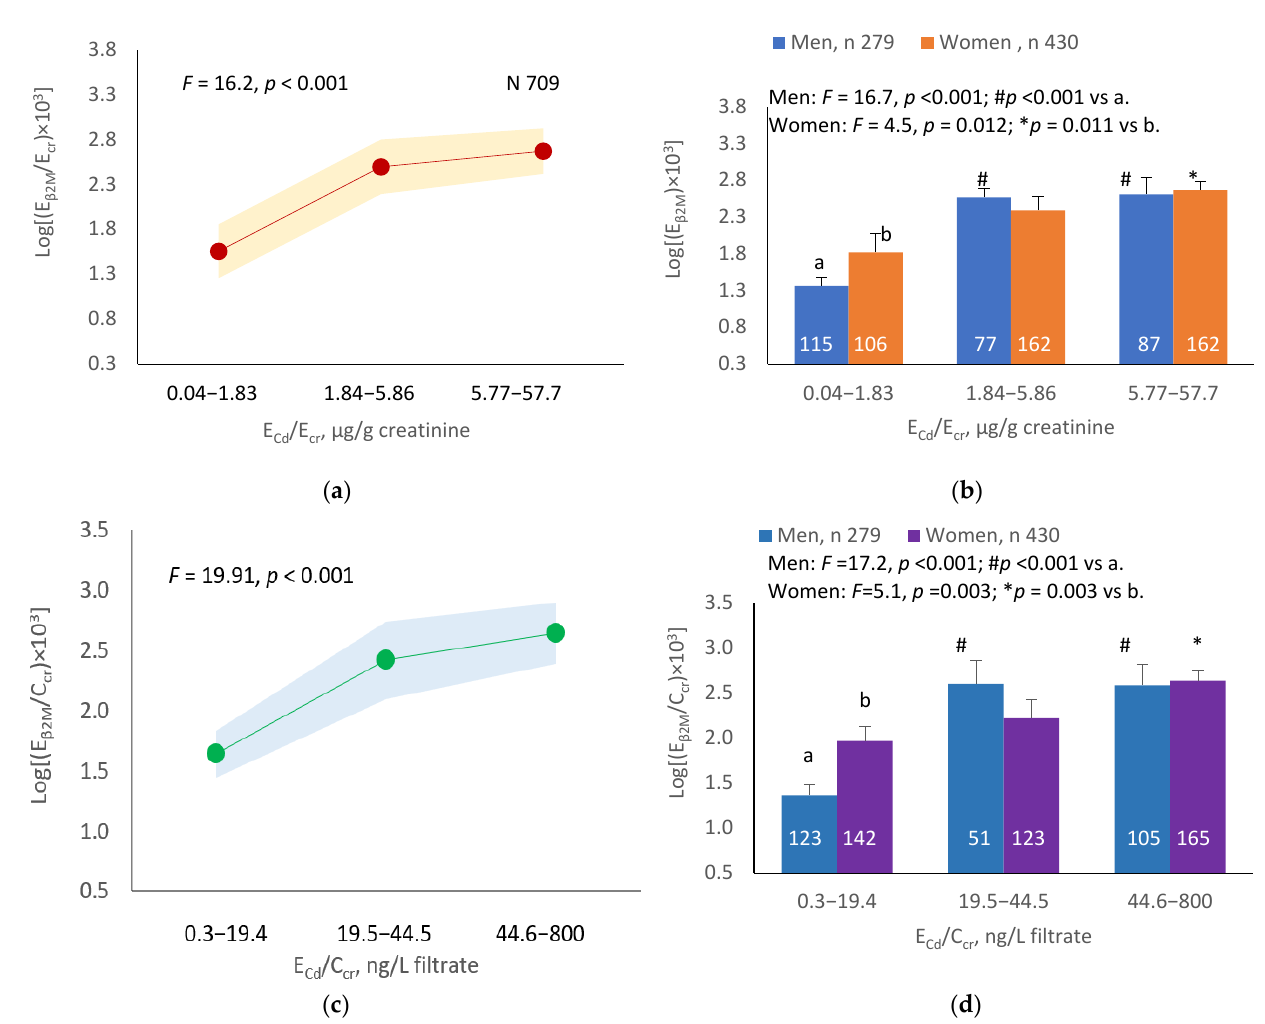
( d ) Figure 2. Cadmium-dose-related increases in NAG excretion. The color-coded area graphs depict NAG excretion means as log[(E NAG /E cr ) × 10 3 ] values with variances for subjects with E Cd /E cr Levels 1, 2 and 3 ( a ) and NAG excretion means as log[(E NAG /C cr ) × 10 4 ] with variances in subjects with E Cd /C cr Levels 1, 2 and 3 ( c ). The bar graphs show NAG excretion means as log[(E NAG /E cr ) × 10 3 ] values in men and women with E Cd /E cr Levels 1, 2, and 3 ( b ) and NAG excretion means as log[(E NAG /C cr ) × 10 4 ] in men and women with E Cd /C cr Levels 1, 2 and 3 ( d ). Where appropriate, statistical comparisons are made within each sex between NAG excretion means in bars a and b. The GM (SD) values of E Cd /E cr at Levels 1, 2 and 3 are 0.51 (0.50), 3.43 (1.10) and 10.94 (7.33) µg/g creatinine, with the corresponding number of subjects being 221, 239 and 249, respectively. The GM (SD) values of E Cd /C cr at Levels 1, 2 and 3 are 5.18 (5.72), 29.6 (6.73) and 97.3 (97.7) ng/L filtrate, with the corresponding number of subjects being 265, 174 and 270, respectively. 3.5.3. Cadmium-Dose-Dependent Increases in β 2 M Excretion The mean E β2M /E cr was highest at E Cd /E cr Level 1, intermediate at Level 2 and lowest at Level 3 ( p < 0.001) (Figure 3a). In men, the mean E β2M /E cr was higher in those with E Cd /E cr Levels 2 and 3, compared with E Cd /E cr Level 1 (Figure 3b). In women, the mean E β2M /E cr at Level 3 of E Cd /E cr was higher than at Level 1 (Figure 3b). Similarly, the mean E β2M /E cr was highest at E Cd /C cr Level 1, intermediate at Level 2 and lowest at Level 3 ( p < 0.001) (Figure 3c), and the mean E β2M /E cr was higher in men with E Cd /C cr Levels 2 and 3, compared with Level 1 (Figure 3d). In women, only the mean E β2M /E cr at Level 3 was higher than at Level 1 (Figure 3d).